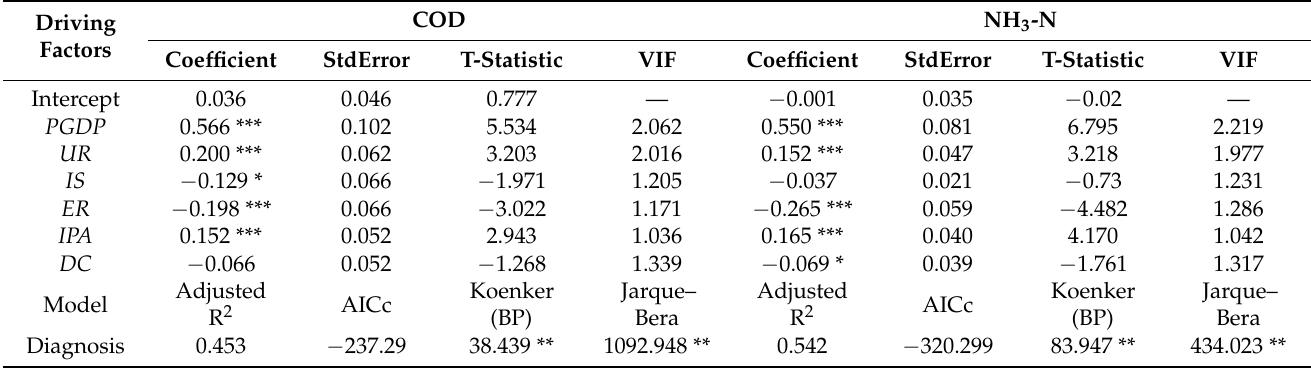
Figure 6. Spatial distribution graph of the regression coefficients of driving factors for COD.